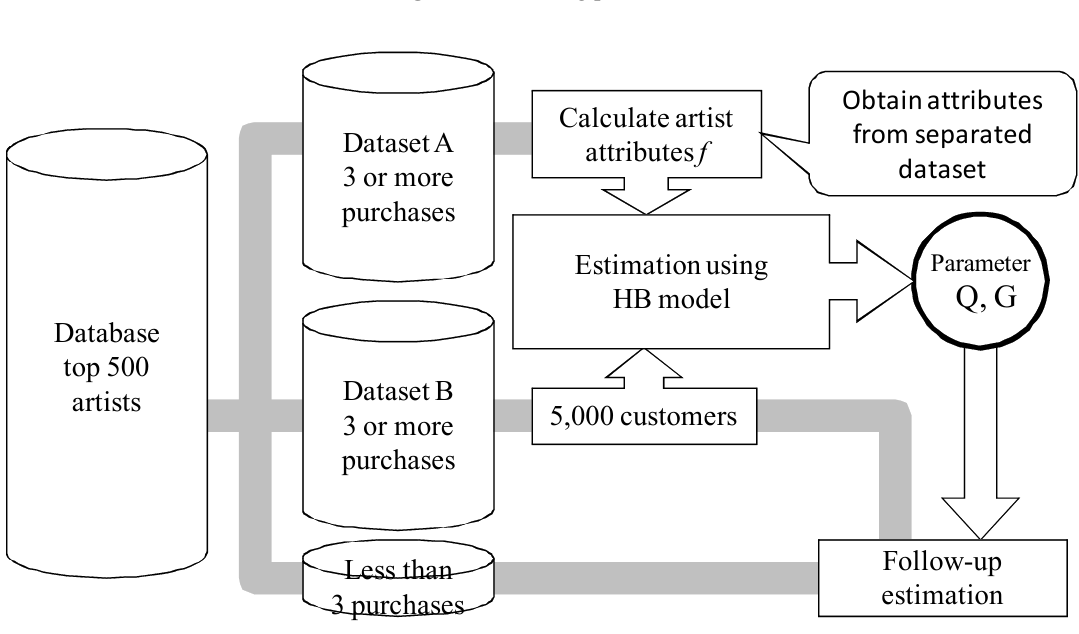
Figure 2. Modeling